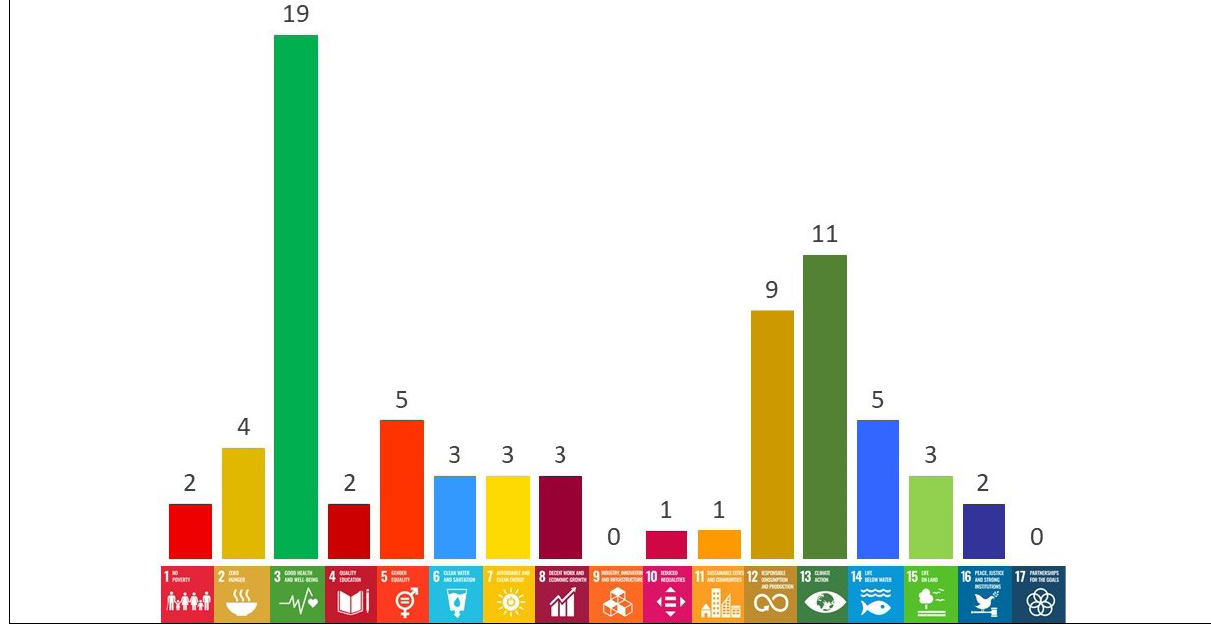
Figure 1: Number of articles published in 2022 that contribute to each of the 17 Sustainable Development